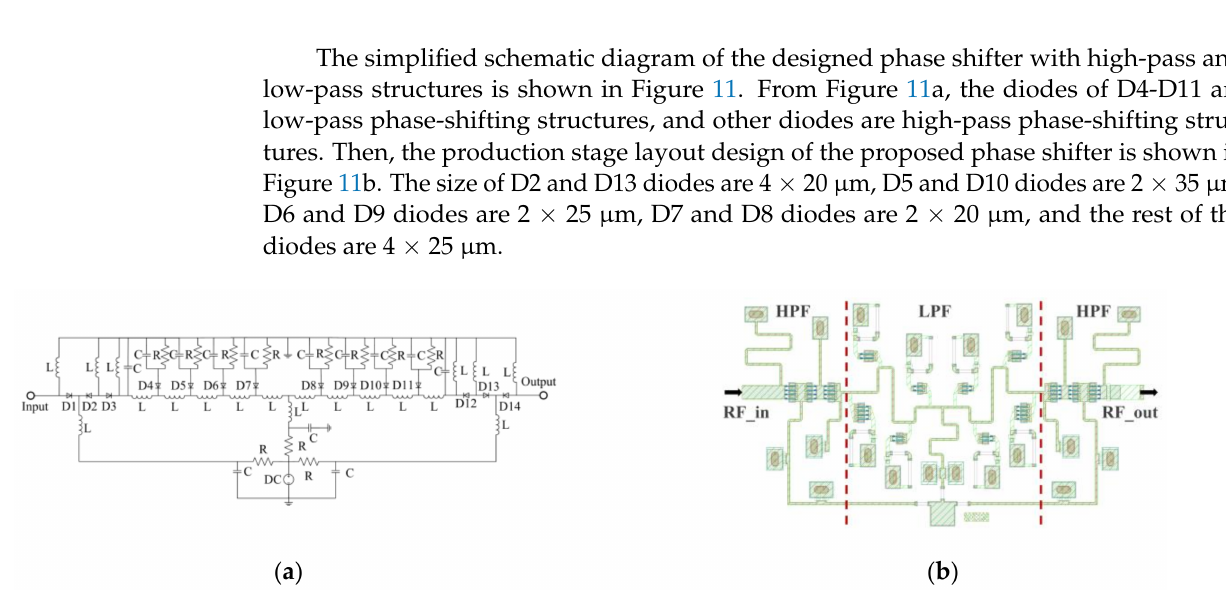
Figure 11. Phase shifter with high-pass and low-pass structure: ( a ) The schematic diagram of the designed phase shifter; ( b ) The layout of the designed phase shifter.